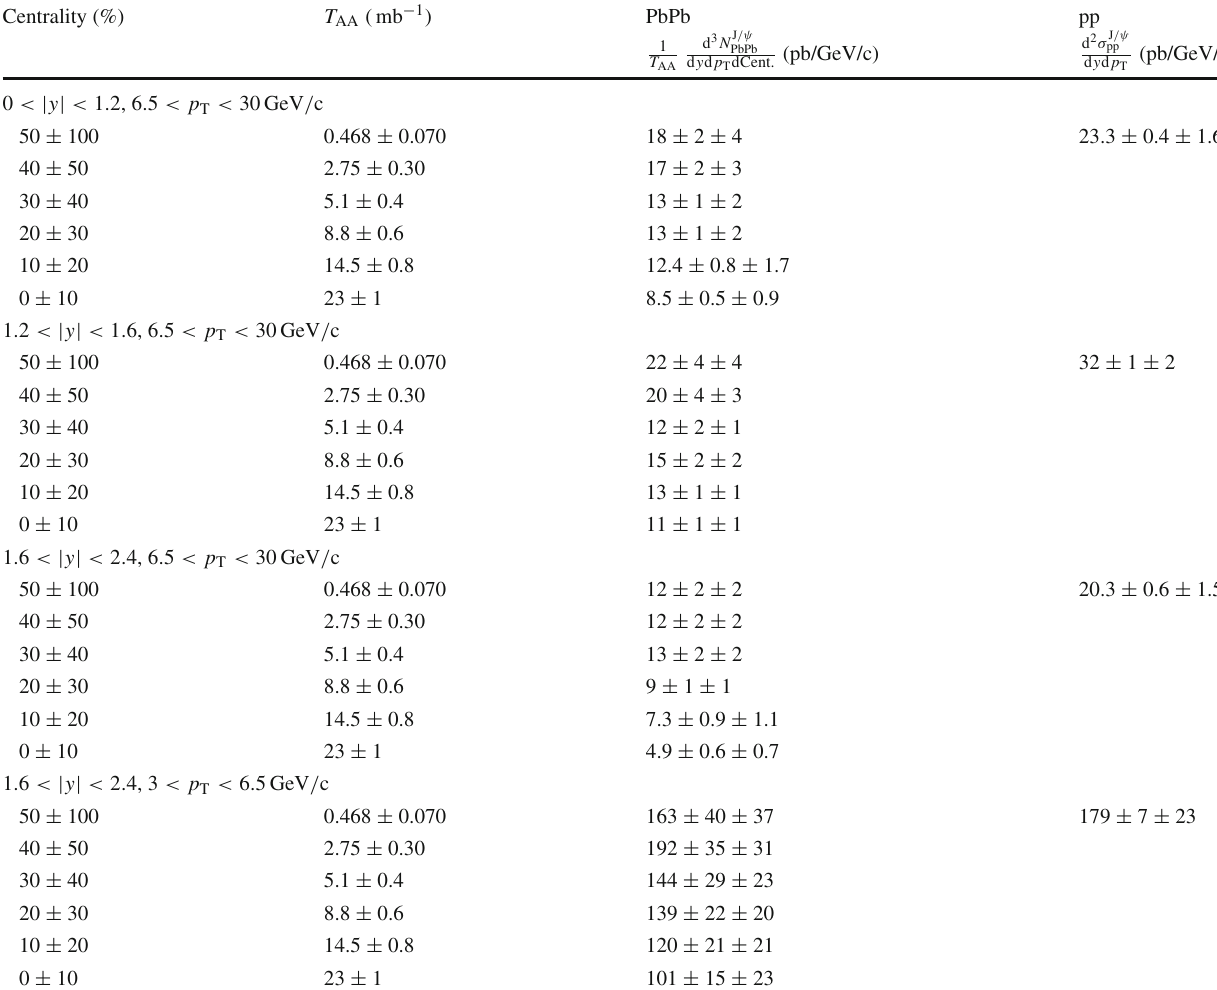
Table 8 The nonprompt J /ψ fiducial cross section in bins of centrality, for three | y | and two p T intervals, measured in PbPb and pp collisions at 2.76TeV within the muon acceptance defined by Eq. (4), and the nuclear overlap function ( T AA , with its systematic uncertainty). Listed